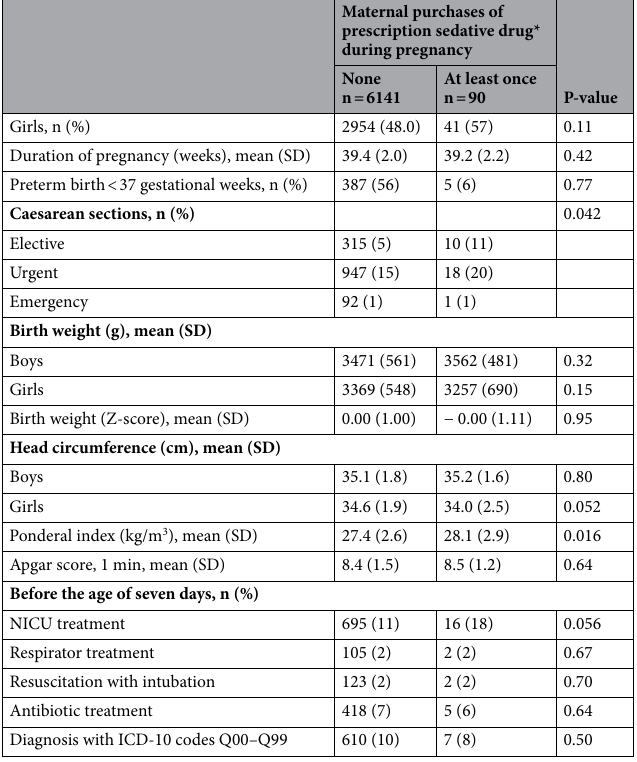
Table 2. Pregnancy (N = 6231) and perinatal outcomes according to maternal purchases of prescription sedative drug during pregnancy. SD standard deviation; NICU care at neonatal intensive care unit;